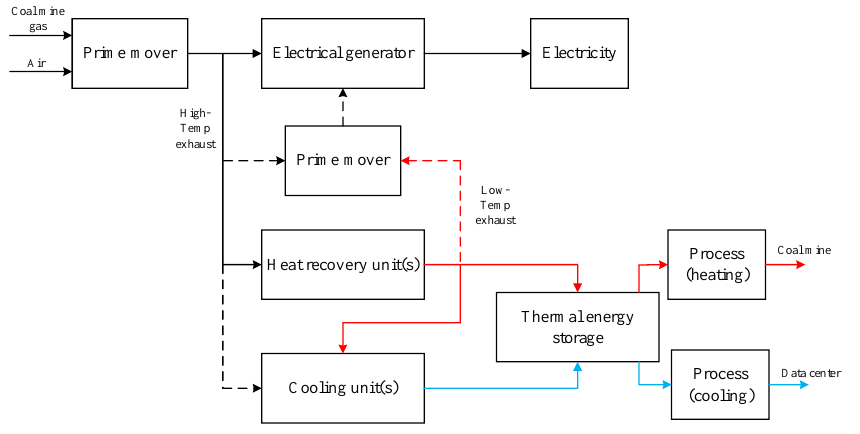
Figure 4. Block diagram of CMM utilization using gas genset.